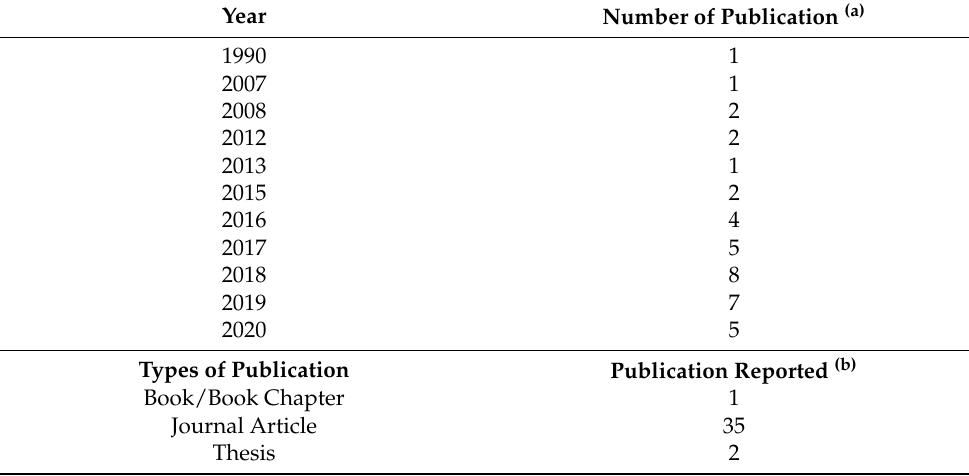
Figure 1. The PRISMA flow diagram showing the selection of eligible studies. Table 4. The trend of publication on natural products in colorectal cancer in Indonesia: ( a ) year vs the number of publications; ( b ) types of publications